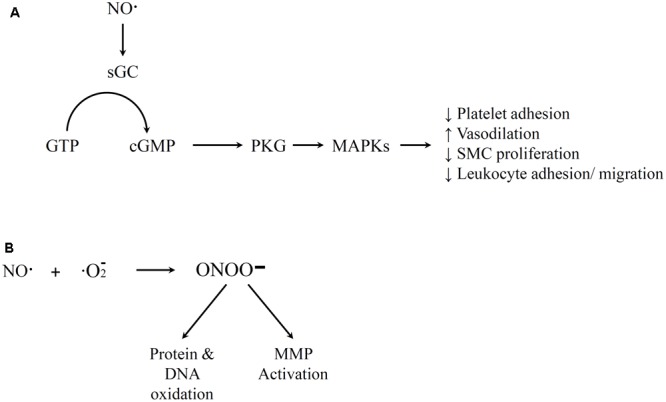
Illustration of nitric oxide (NO) Pathways. (A) Positive medical effects that involve guanylate cyclase activation by NO, conversion of guanosine triphosphate (GTP) to cGMP, and activation of downstream PKG that lead to various vascular homeostasis impacts. (B) Free radical reaction of NO and oxygen that yields peroxynitrite that leads to negative impacts of NO. References for this figure are listed in the text.